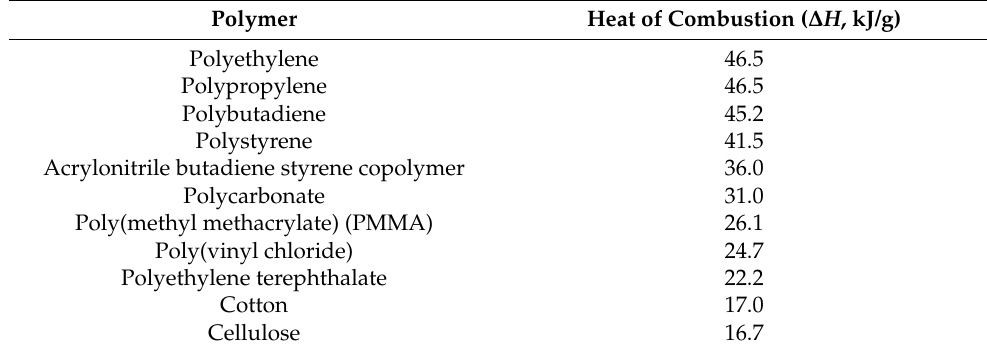
Figure 4. Combustion cycle of polymers. Reprinted with permission from Ref. [35]. Copyright 2016, MDPI AG. Table 1. Combustion heats of several polymers in common use. Reproduced with permission from Ref. [35]. Copyright 2016, MDPI AG.